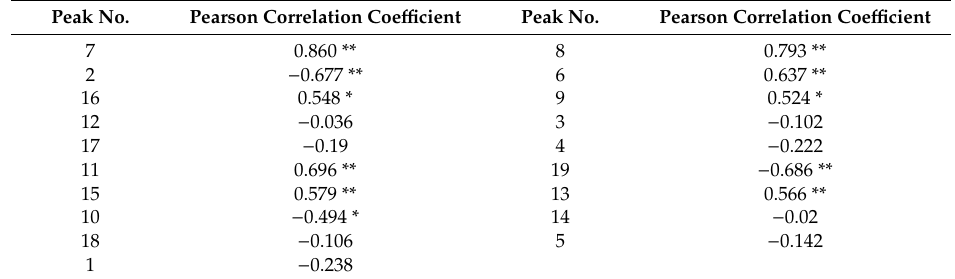
Table 7. The correlation coe ffi cients between characteristic peaks and A549 cell proliferation inhibition rate. Peak